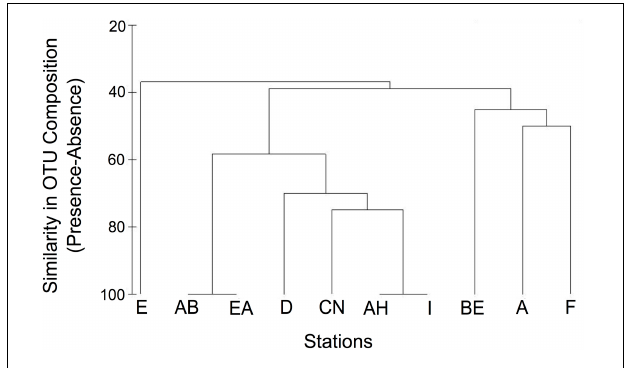
FIGURE 3 | Similarity in Desulfotomaculum OTU composition among sampling stations based on presence-absence of 10 OTUs.